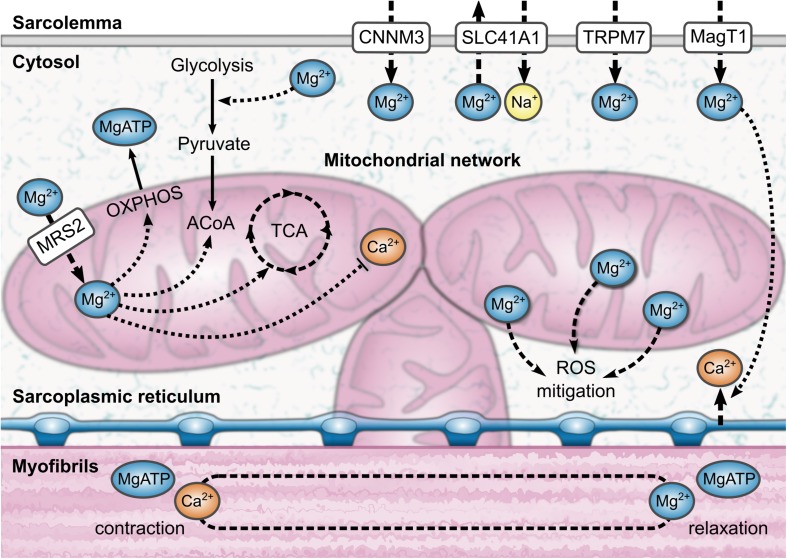
An illustration of the aspects of intramuscular magnesium physiology that can be observed using phosphorus magnetic resonance spectroscopy (31P-MRS). MRS is sensitive to the influence of magnesium complexation on the adenosine triphosphate molecule; this information can be used to estimate the bound magnesium fraction, and thus the proportion of free ionized magnesium, Mg2+. In brief, magnesium is involved in transport across the sarcolemma, energetic metabolism, and muscle contraction and relaxation. A third of the total magnesium content of a muscle cell can be found inside mitochondria. Magnesium also mitigates reactive oxygen species (ROS) in the cell through several mechanisms. ACoA, acetyl coenzyme A; CNNM3, cyclin M3; MagT1, magnesium transporter 1; MRS2, mitochondrial RNA splicing 2; OXPHOS, oxidative phosphorylation; SLC41A1, solute carrier family 41 type 1; TCA, tricarboxylic acid cycle; TRPM7, transient receptor potential melastatin type 7.